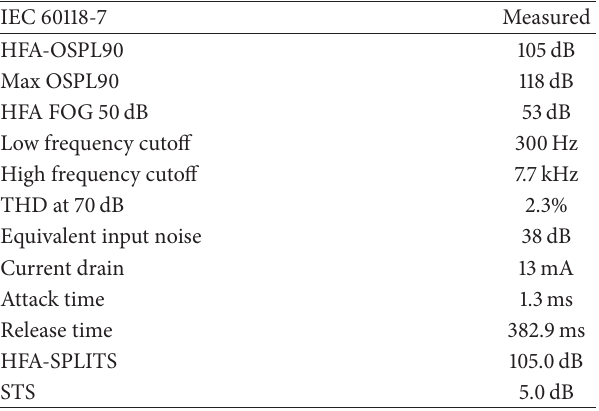
Figure 3: HA-TEST. Table 3: PDN-01B electroacoustics measurements.